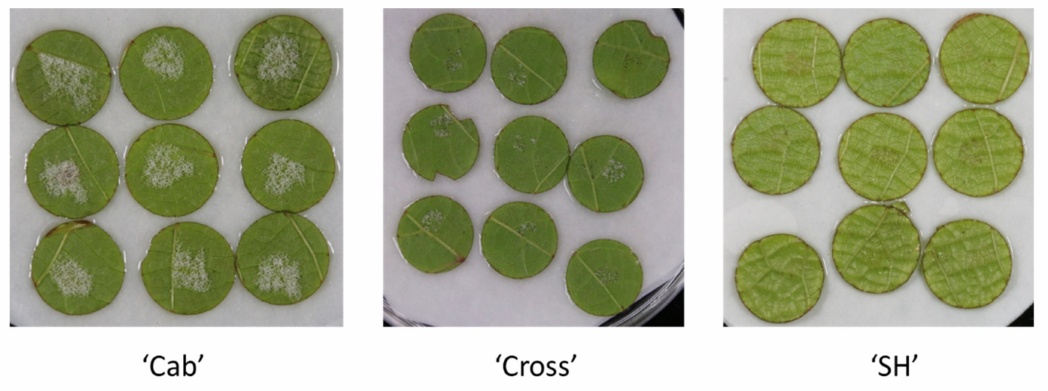
Figure 1. Grapevine downy mildew symptoms on leaf disks with different sporulation density observed at 7 days post- inoculation. “Cab”: Vitis vinifera cv. “Cabernet sauvignon”; “SH”: Vitis amurensis cv. “Shuanghong”; “Cross”: the hybrid from “Cab” and